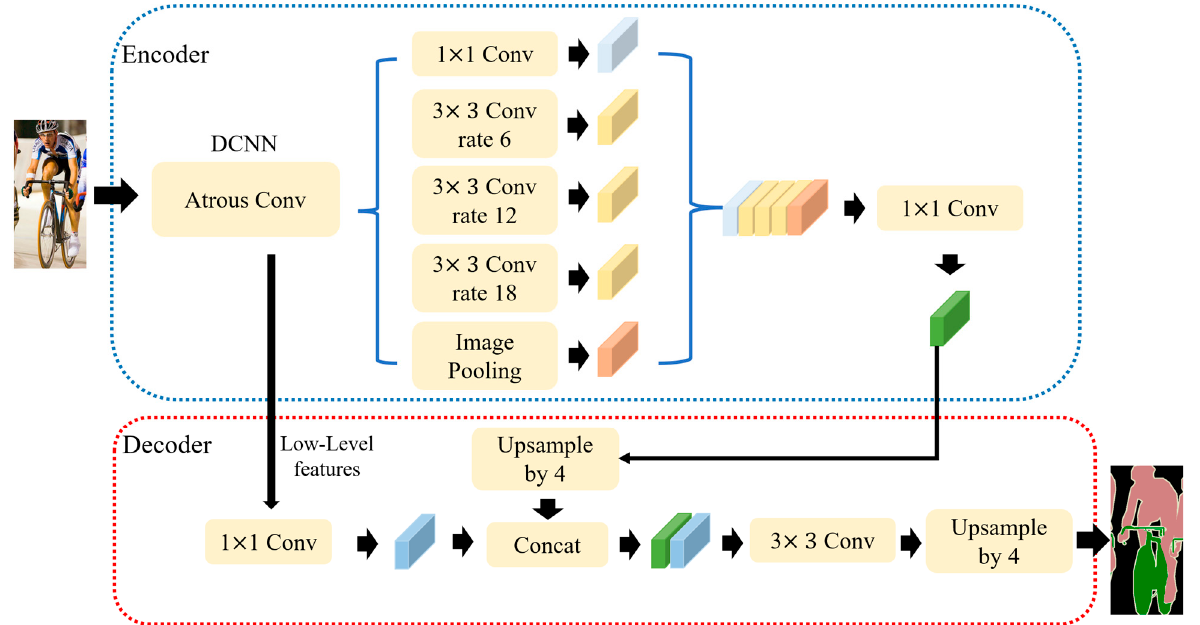
Figure 3. Schematic diagram of DeepLabv3+ network architecture. Adapted from